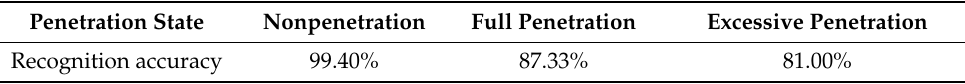
Table 8. Recognition accuracy of the penetration state by using